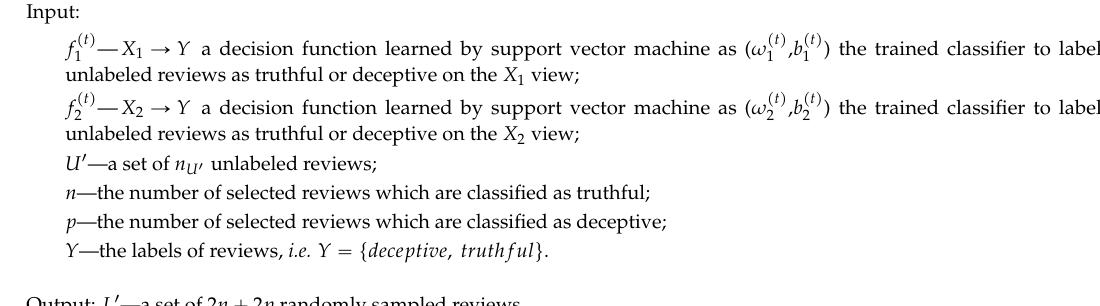
Algorithm 3. The CoSpa-U